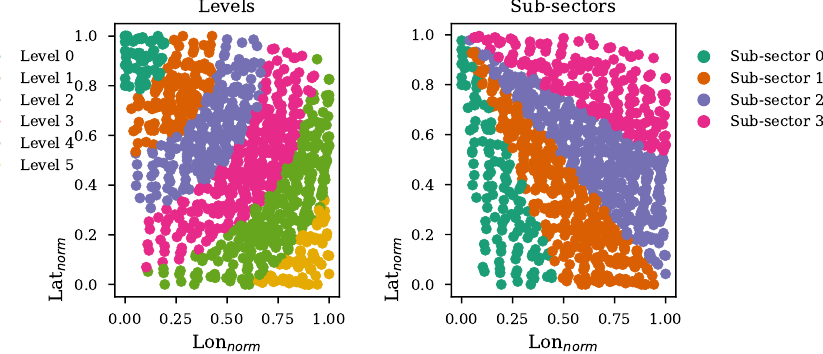
Figure 7. Levels and sub-sectors. We perform a feature construction by dividing the normalized sector into sub-regions: levels and sub-sectors . For the convenience of visualization, data points from one day of analysis were used for the preparation of the